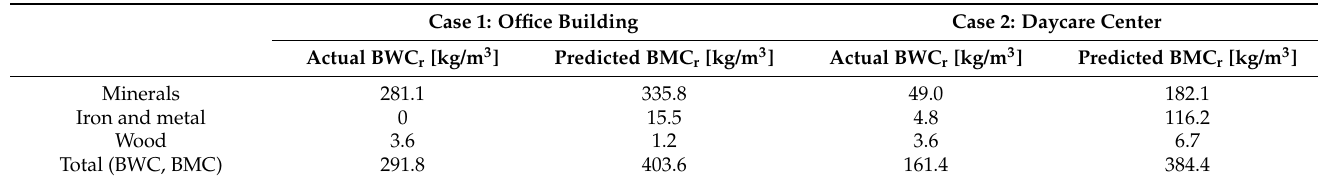
Table 3. Two cases comparing predicted building material compositions vs. actual measured building material